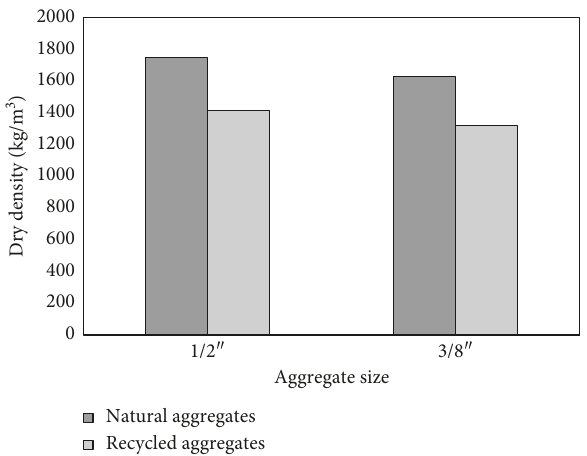
Figure 1: Grading of natural and recycled 1/2